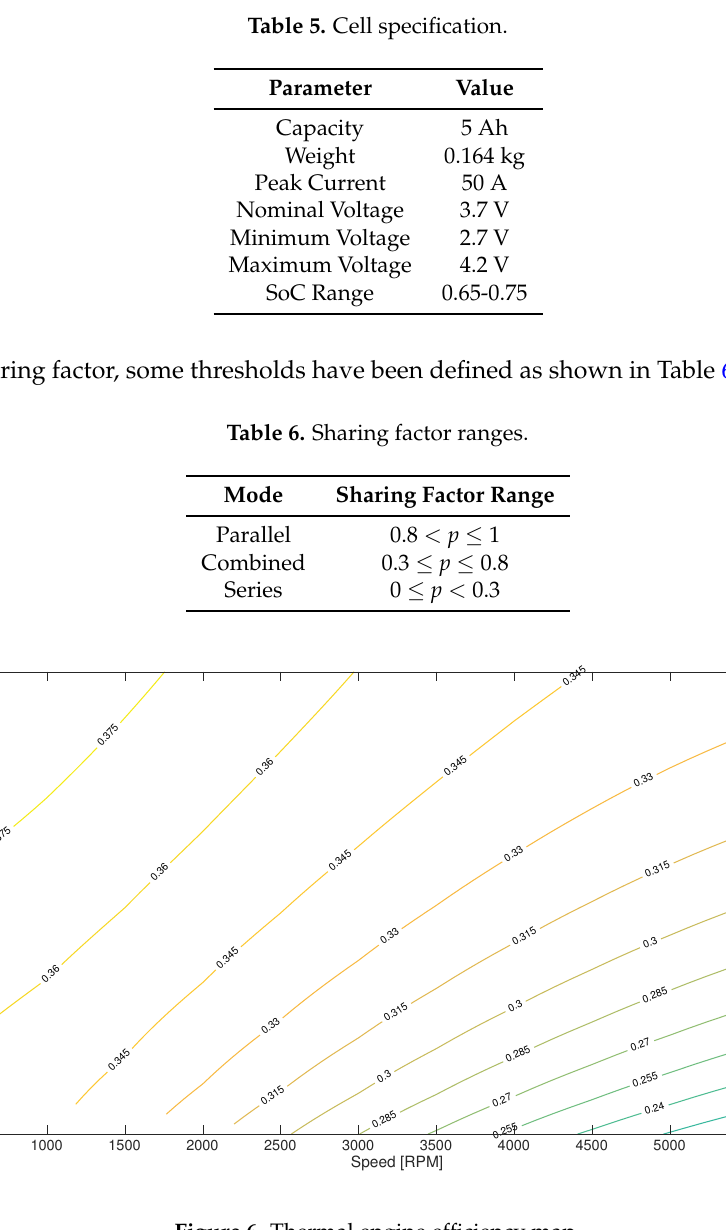
Figure 6. Thermal engine efficiency